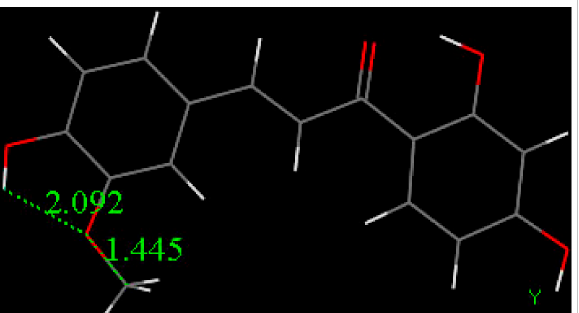
Figure 15. DFT geometry optimization of an isolated molecule of Homobutein, shows an intramolec-